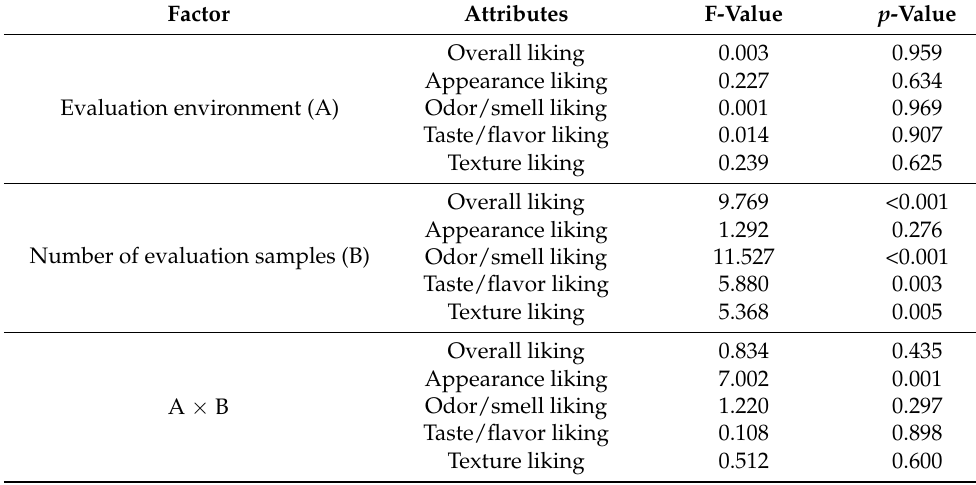
Table 4. Effect of the evaluation environment and the number of evaluation samples on the liking ratings for the vegan ramen test target sample.